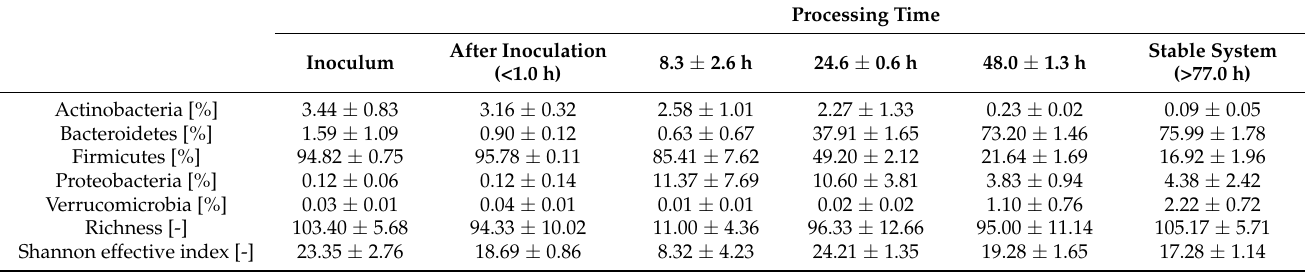
Table 3. Evolution of microbial composition, richness and diversity of inoculum during cultivation of donor A.